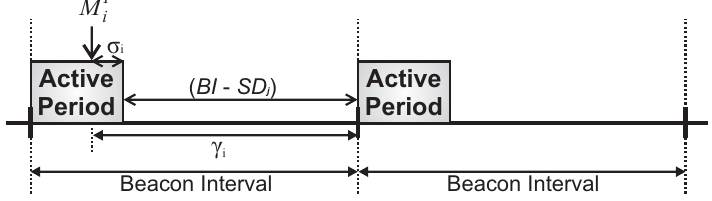
Figure 10. Local worst-case response time for a message